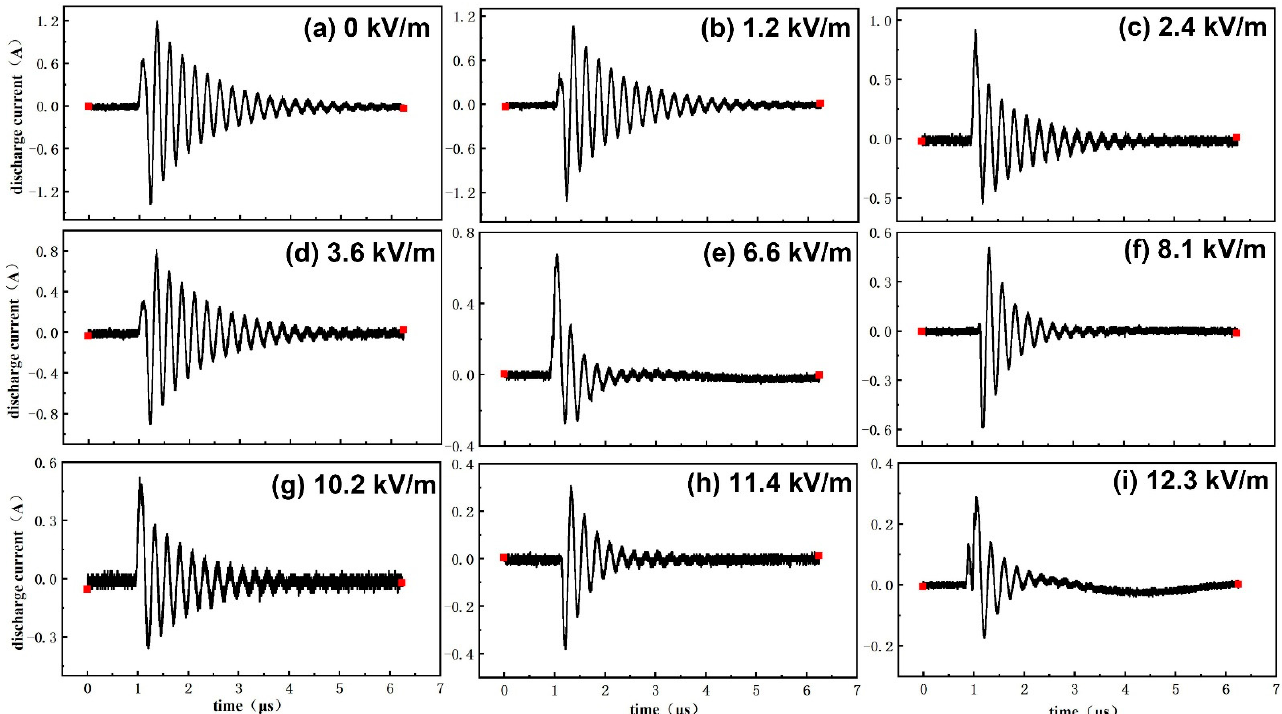
Figure 8. Discharge waveform of solar array irradiated by electron beam under ESD EMP radiation with different peak value; ( a ) 0 kV/m; ( b ) 1.2 kV/m; ( c ) 2.4 kV/m; ( d ) 3.6 kV/m; ( e ) 6.6 kV/m; ( f ) 8.1 kV/m; ( g ) 10.2 kV/m; ( h ) 11.4 kV/m; ( i ) 12.3 kV/m.